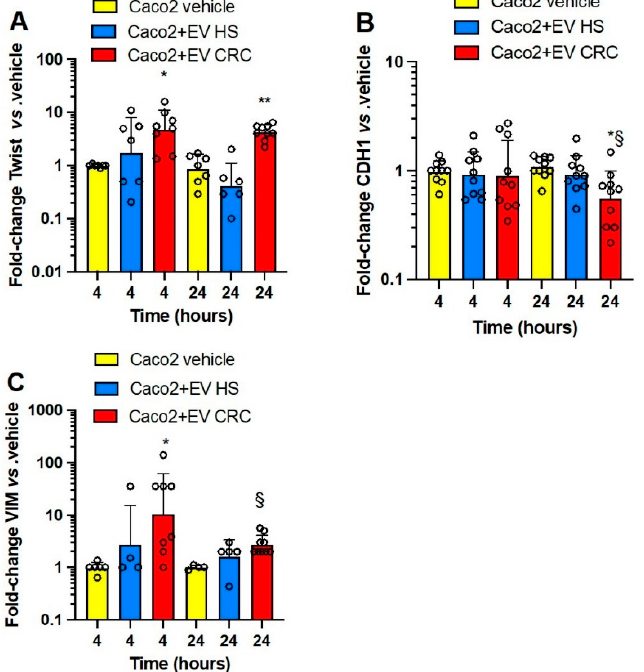
Figure 6. Effects of platelet-derived mEVs on the expression of gene markers of EMT in cocultures with the human colon adenocarcinoma cell line Caco2. Cancer cells (0.5 × 10 6 ) were incubated for 4 or 24 h with CRC or HS EVs (100 µ g), and the gene expression of TWIST1 ( A ), CDH1 (protein name E-cadherin) ( B ), and VIM (protein name vimentin) ( C ) was evaluated by qPCR and normalized to those of GAPDH and reported as fold-change vs. the gene expression detected in the cocultures of mEV from HS with the cancer cells. The values were not normally distributed and were transformed to logarithms, and all values are shown as scatter dot plots with mean + SD, n = 4–9, and analyzed by one-way ANOVA followed by Tukey’s multiple comparisons test. ( A ) TWIST1 , 4 h, * p < 0.05 vs. vehicle, 24 h ** p < 0.01 vs. vehicle and EV HS; ( B ) CDH1 , 24 h, * p < 0.05 vs. EV HS, § p < 0.01 vs. vehicle; ( C ) VIM , 4 h, * p < 0.05 vs. vehicle, 24 h, § p < 0.01 vs. vehicle. Altogether these results show that platelet-derived mEVs from CRC patients altered EMT marker gene expression in four human colorectal cancer cell lines. Differently from the results on the other three cancer cell lines, the CDH1 expression of HCA7 cells was not significantly affected by mEVs from CRC patients. The effects of platelet-derived mEVs from HS were overall not statistically significant. 3.4. Effects of Platelet-Derived mEVs on the Expression of PTGS2 and TXB 2 Generation by Colorectal Cancer Cells We aimed to verify the impact of the interaction of platelet-derived mEVs of CRC patients and HS on PTGS2 expression in the four colorectal cancer cell lines (Figure 7A– D). At baseline, HCA7 cells showed a higher expression of PTGS2 than that detected in the other four cancer cell lines, which presented comparable low gene expression (from 0.01 to 2% of that found in HCA7 cells) (Figure S1). The coculture of the four cancer cell lines with platelet-derived mEVs of CRC patients significantly induced PTGS2 , mainly at 24 h (Figure 7A–D); in contrast, mEVs of HS did not significantly affect PTGS2 gene expression.